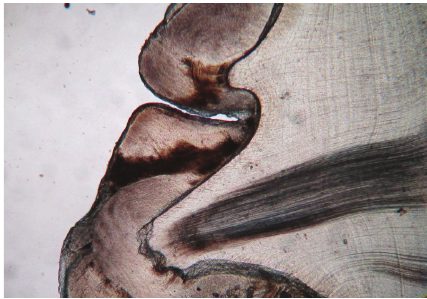
Figure 9: Dead tracts and gnarled enamel (photomicrograph, ground section 10x).